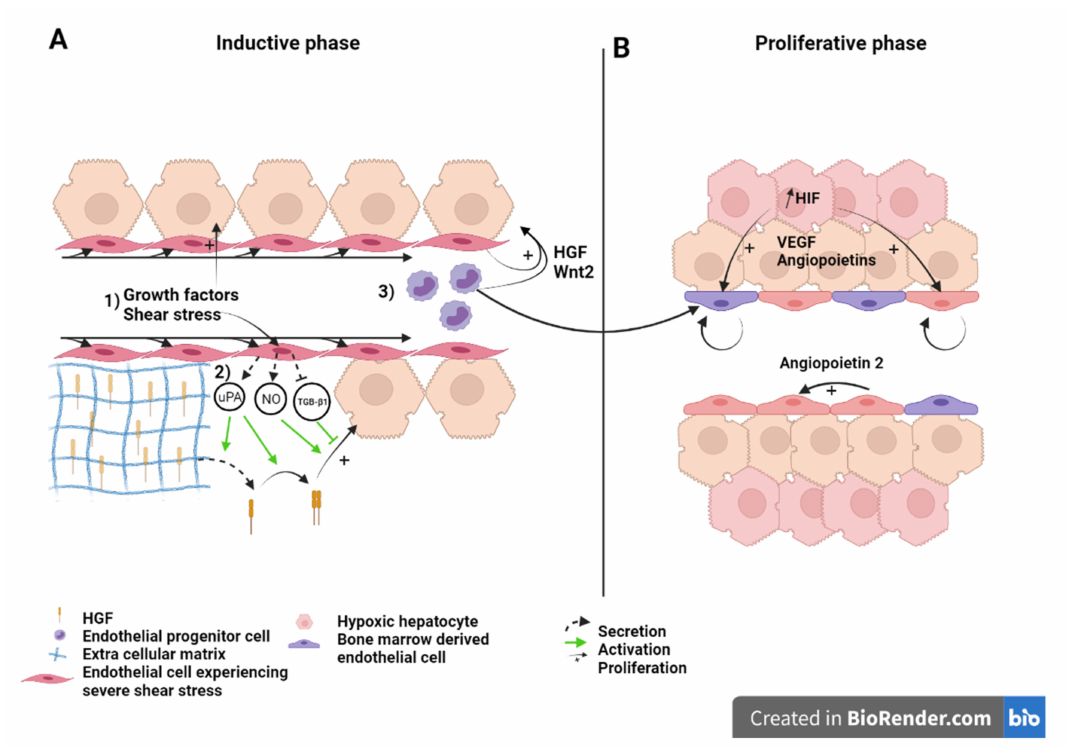
Figure 2. Liver sinusoid and endothelial cells during the ( A ) inductive phase and ( B ) angiogenic phase of liver regeneration after partial hepatectomy. Scheme on the role of LSEC during regeneration after partial hepatectomy during the inductive phase ( A ) where (1) growth factors, (2) increased shear stress, as well as (3) bone marrow endothelial progenitors induce the proliferation of the hepatocytes. This is also overused during the proliferative phase ( B ), where LSEC upregulate angiopoietin-2 paracrine secretion and proliferating hepatocytes, which experience a relative hypoxia, secrete pro-angiogenic factors to induce the proliferation of LSEC. Recruited endothelial progenitor cells become LSEC during regeneration. HGF: Hepatic growth factor; NO: Nitric oxide; TGB- β 1: Tumor growth factor beta 1; Wnt2: Wingless-type MMTV integration site family, member 2; HIF: Hypoxia inducible factor; VEGF: Vascular endothelial growth